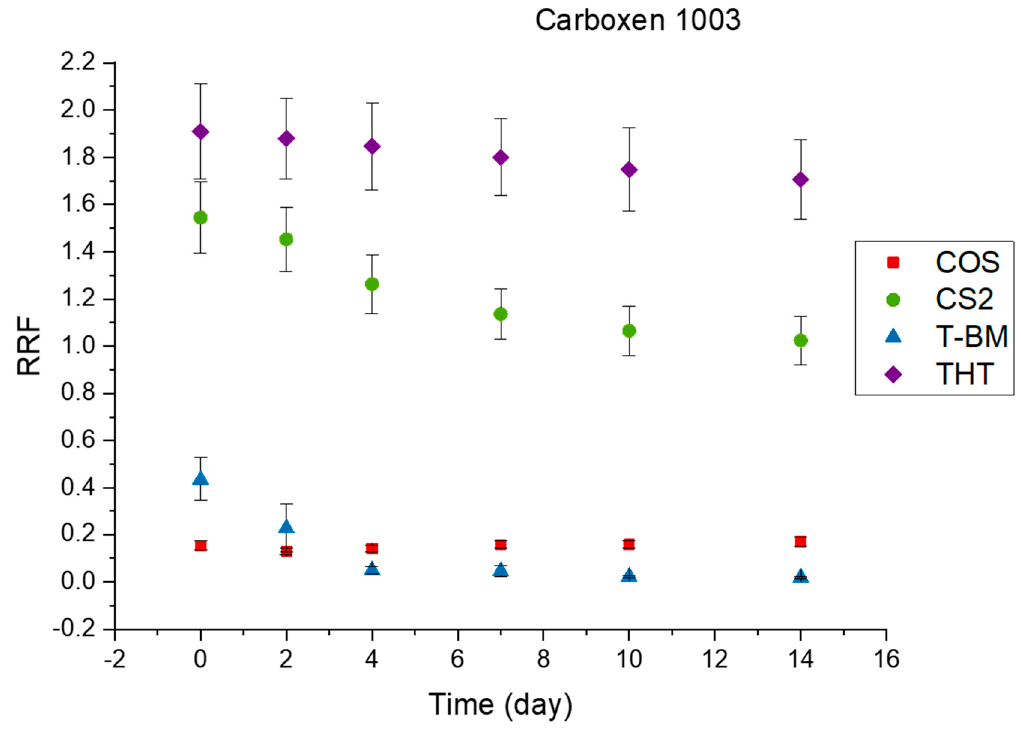
Figure 10. Storage stability of sulphur compounds (~100 nmol/mol) on Carboxen 1003.